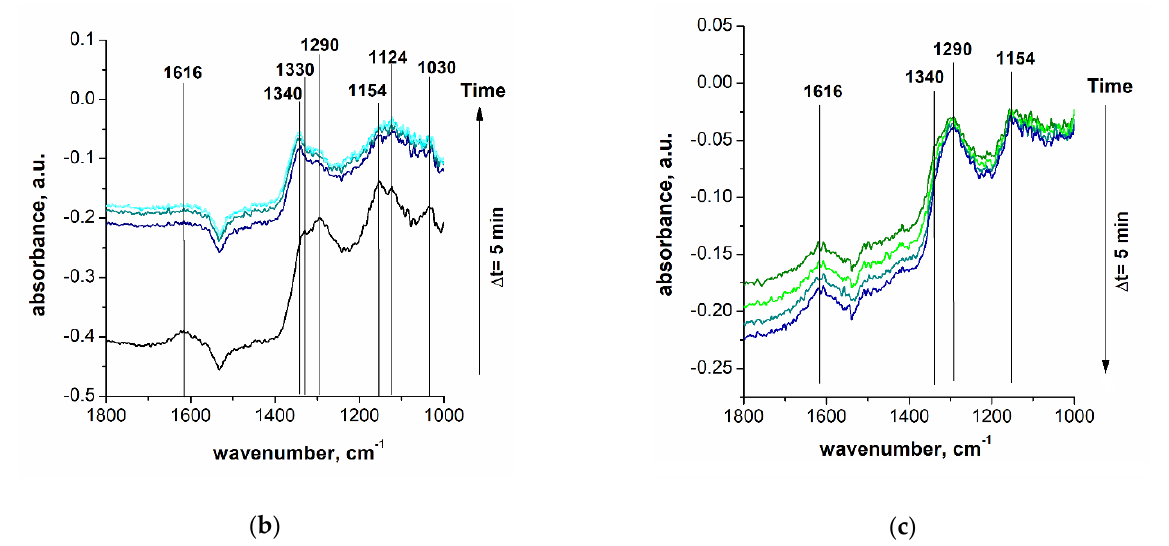
Figure 9. Co 3 O 4 DRIFT spectra: ( a ) 20 ppm H 2 S in dry air at 220 °C; ( b ) Annealing in dry air at 300 °C; ( c ) Humid air (60% R.H.) at 220 °C.